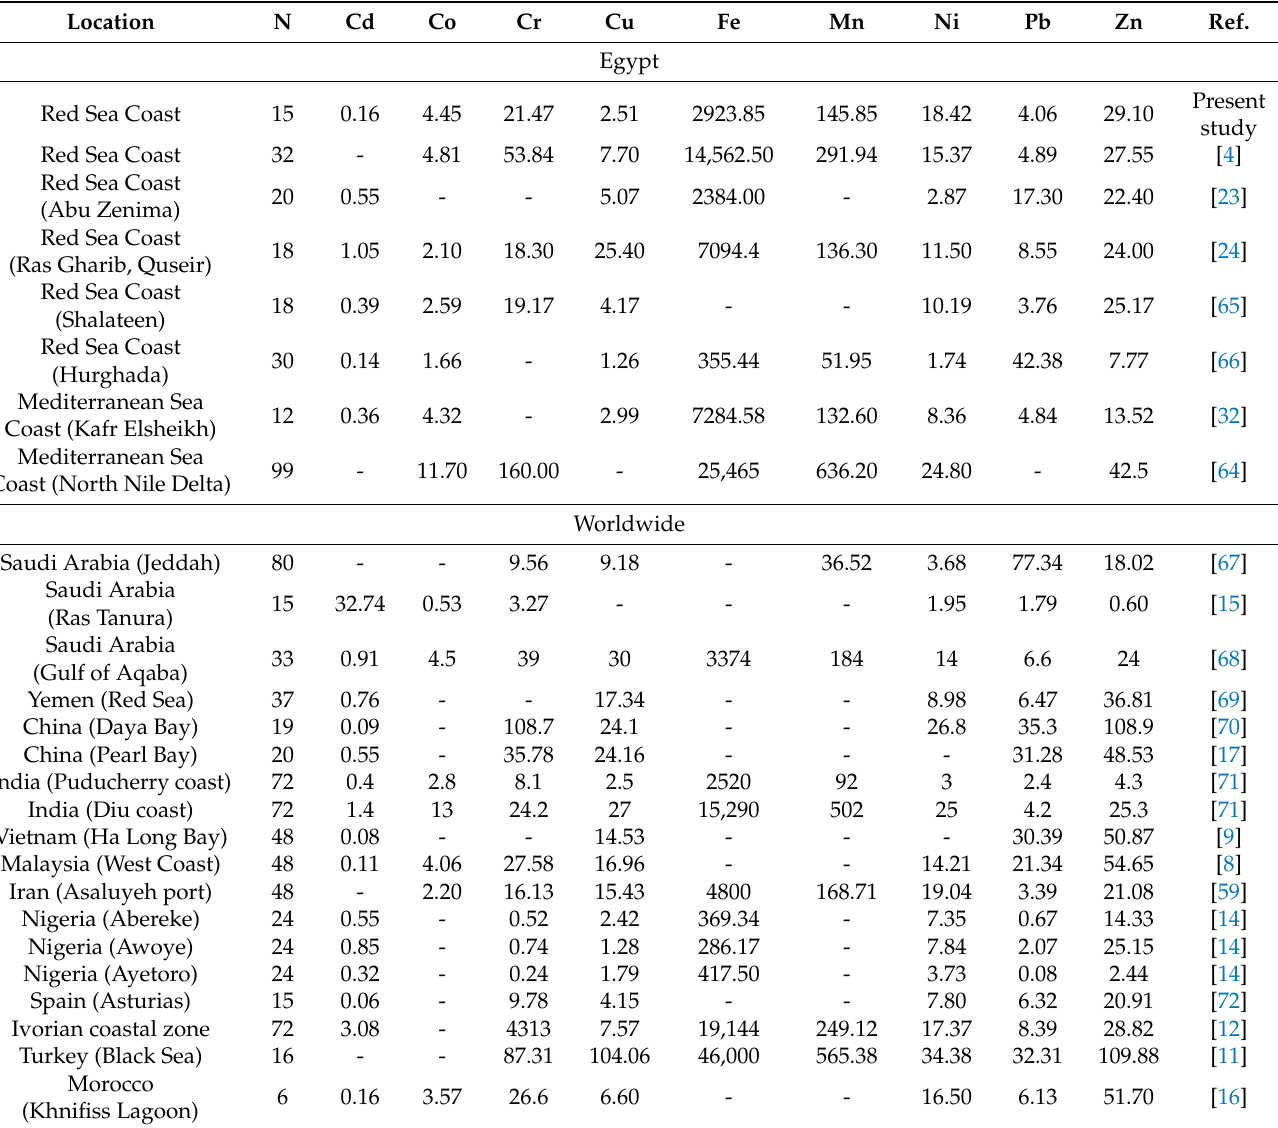
Table 4. Comparison of PTEs concentration in marine sediments reported in the various regions of Egypt and